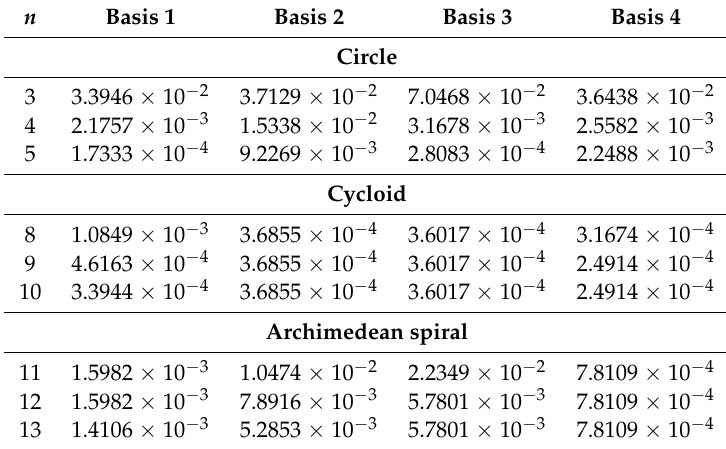
Table 1. Loss values of the mean absolute error (12) for different fitting curves of degree n with f ( t ) = t , g ( t ) = 1 − t , t ∈ [ 0,1 ] (Basis 1), f ( t ) = t 2 and g ( t ) = 1 − t 2 , t ∈ [ 0,1 ] , (Basis 2), f ( t ) = sin (( ∆ + t ) /2 ) and g ( t ) = sin (( ∆ − t ) /2 ) , ∆ < π /2, ∆ < π /2, t ∈ [ − ∆ , ∆ ] , (Basis 3) and finally f ( t ) = sinh (( ∆ + t ) /2 ) and g ( t ) = sinh (( ∆ − t ) /2 ) , ∆ < π /2, t ∈ [ − ∆ , ∆ ] , (Basis 4). They were all trained with 4000 iterations, α = 0.0001, β 1 = 0.9, β 2 = 0.999, ε = 10 − 7 . The process was repeated 5 times, with the loss values provided being the best values reached. n Basis 1 Basis 2